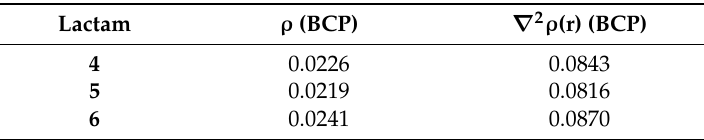
Table 5. Values of electron density and Laplacian of electron density in the C − H α ··· O bond critical